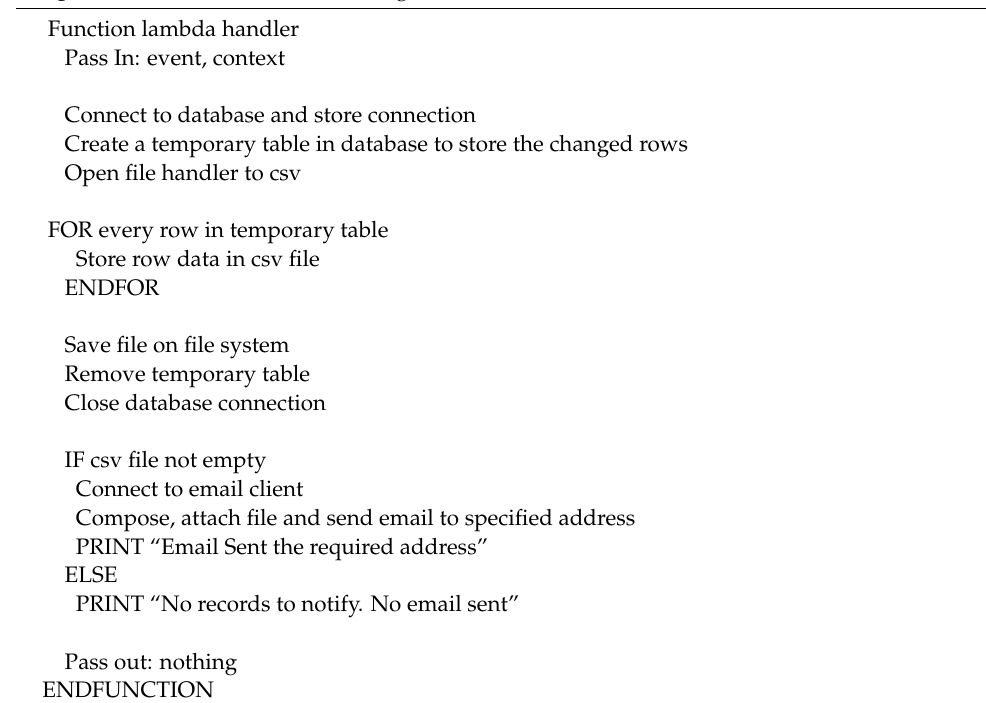
Algorithm 1 AWS order workflow